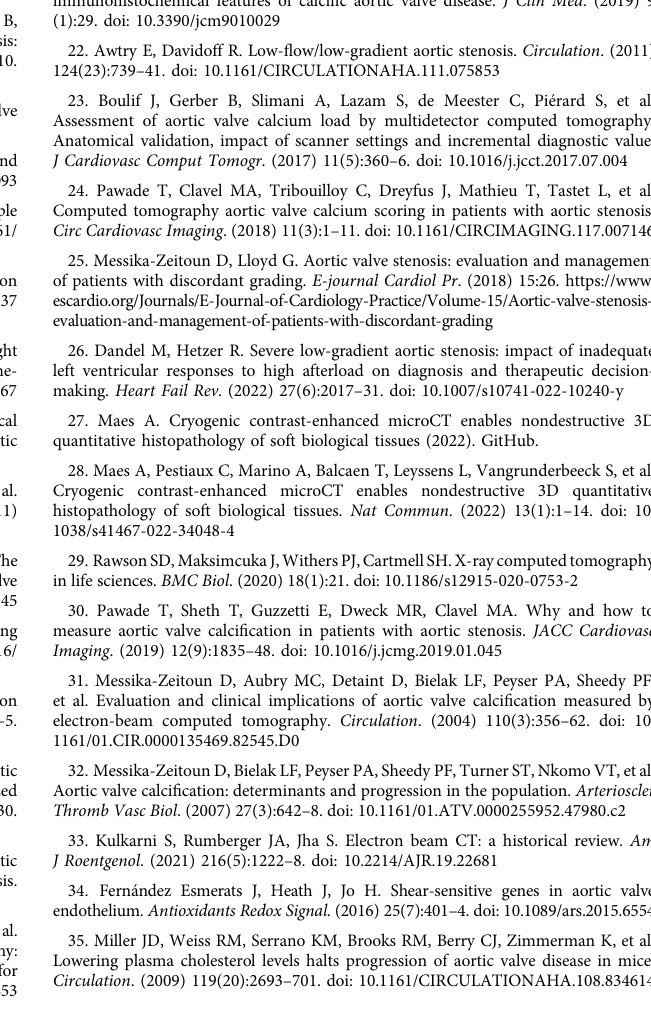
SUPPLEMENTARY MOVIE S1 Distinctionofthreelevelsofdensitywithinthecalci fi cations.Ortho-slices(right) and 3D renderings (left) of cusps N1.1 and H5.2. The horizontal white lines present in the 3D renderings correspond to the location of the ortho-slices. Softtissue isshownindarkgrayonortho-slices and inredin the3D